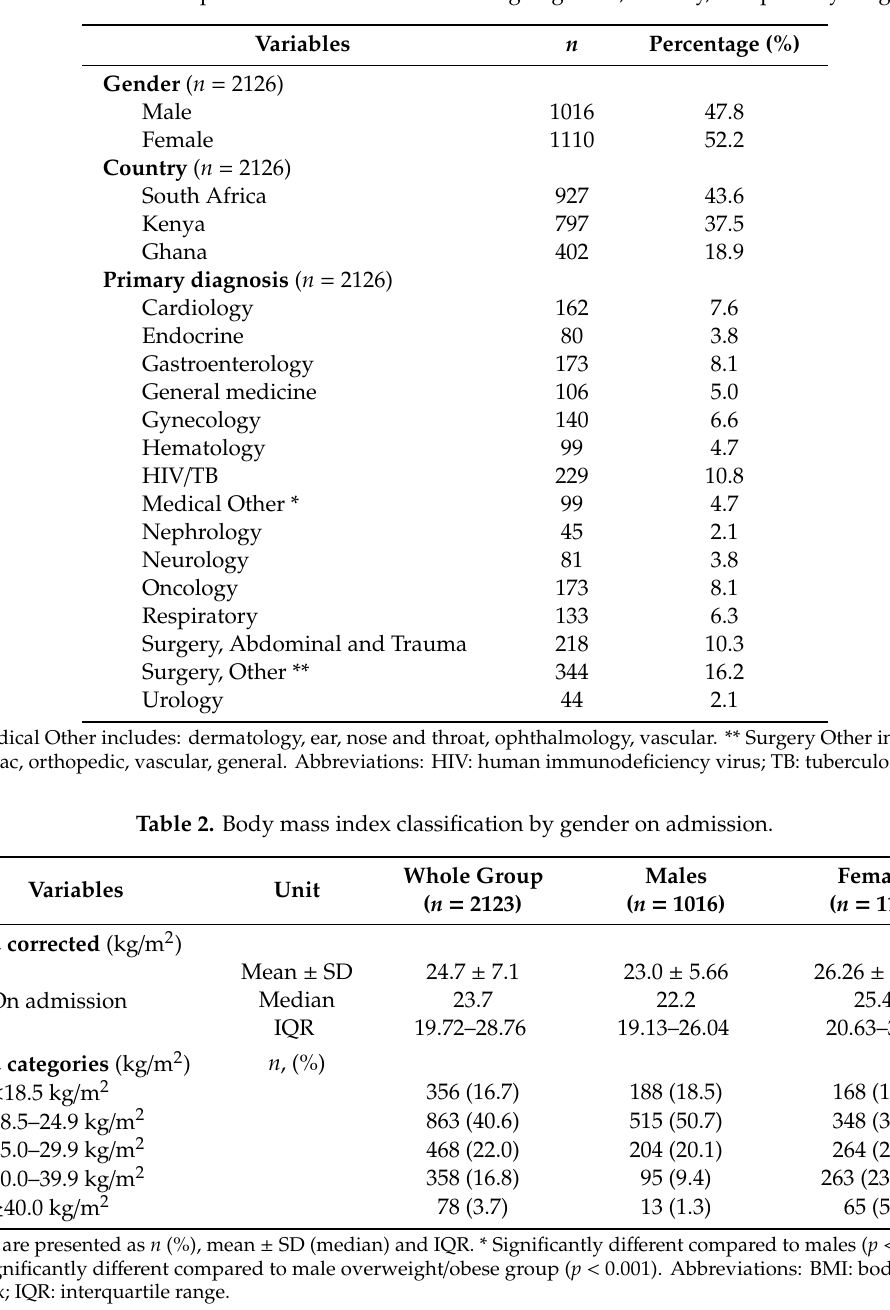
Table 1. Distribution of patients on admission according to gender, country, and primary diagnosis.